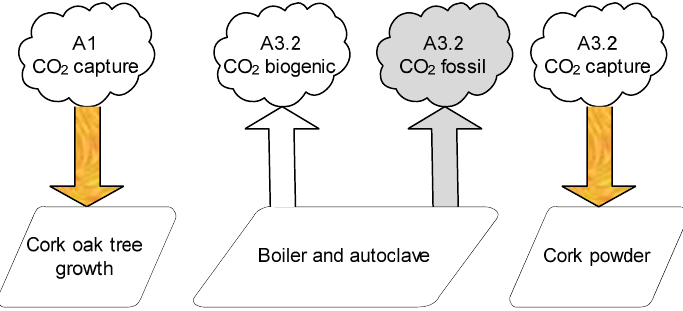
Figure 5. CML only considers CO 2 fossil emissions (in grey) and does not consider CO 2 capture during tree growth or biogenic CO 2 emissions.